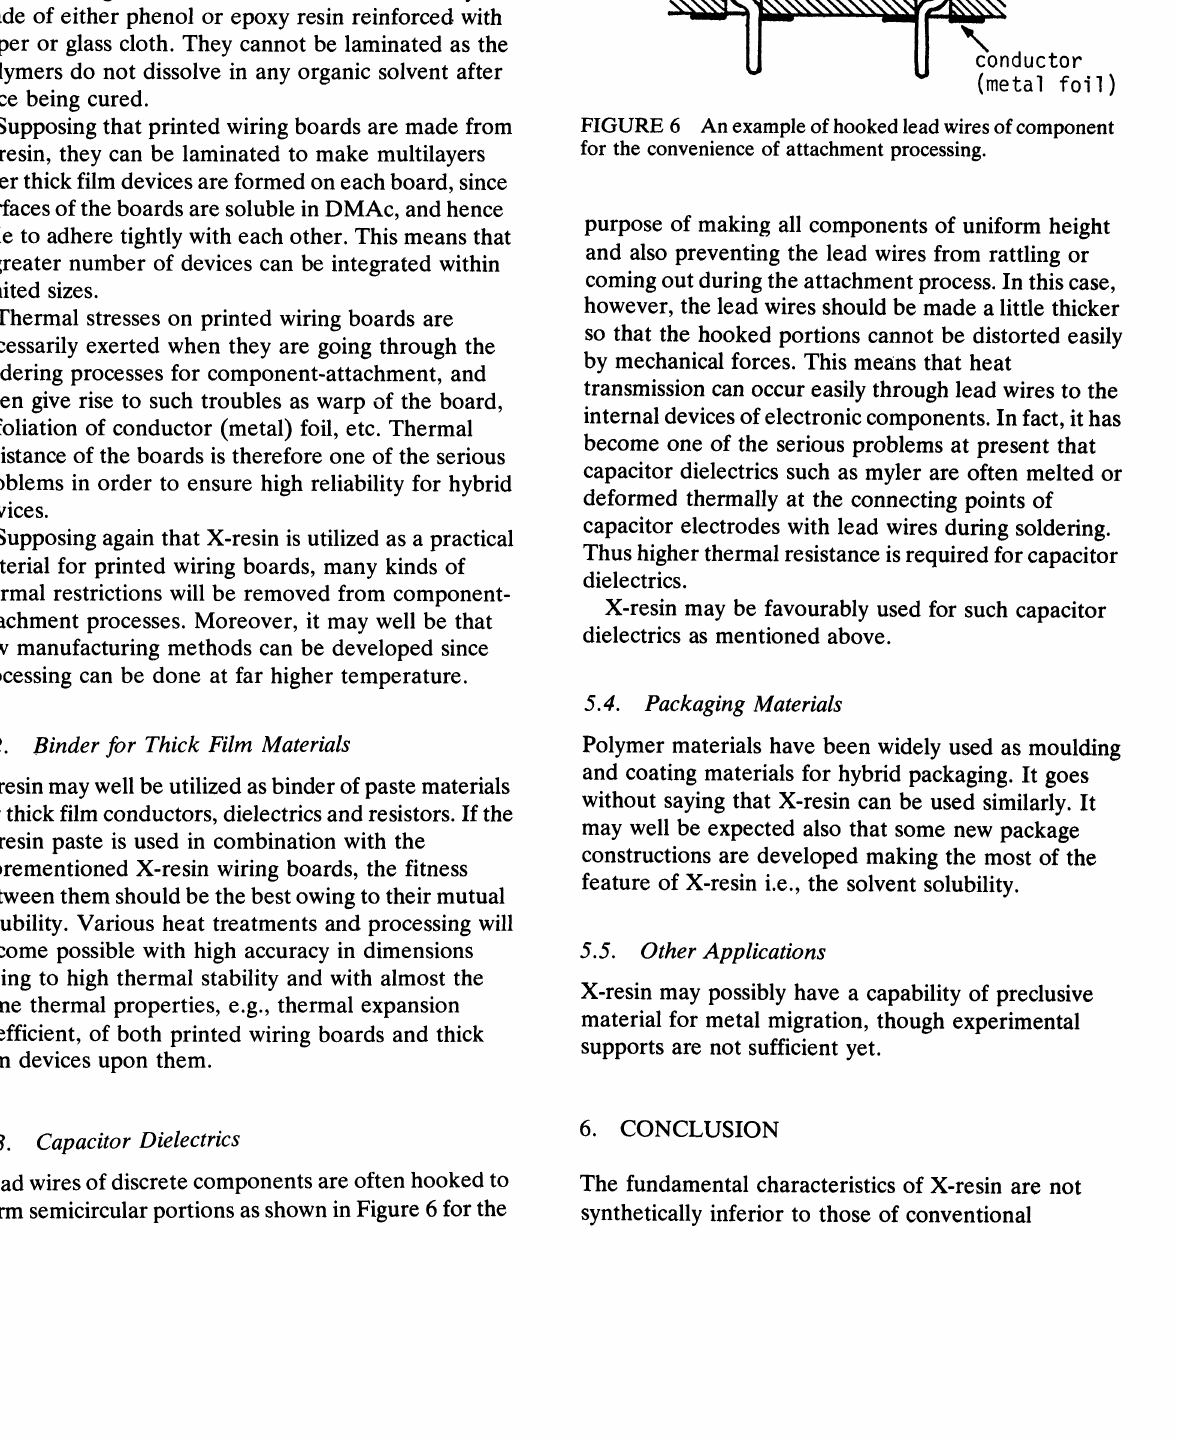
FIGURE 6 An example ofhooked lead wires of component for the convenience of attachment